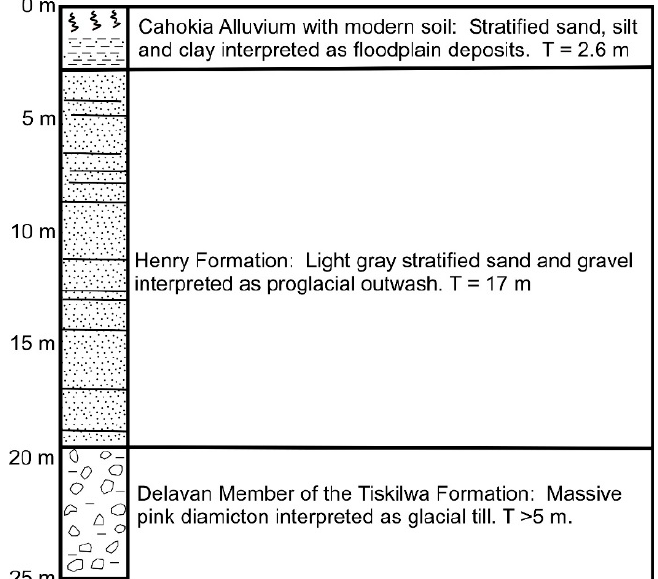
Figure 4. Lithologic log of sediments present in BH01.